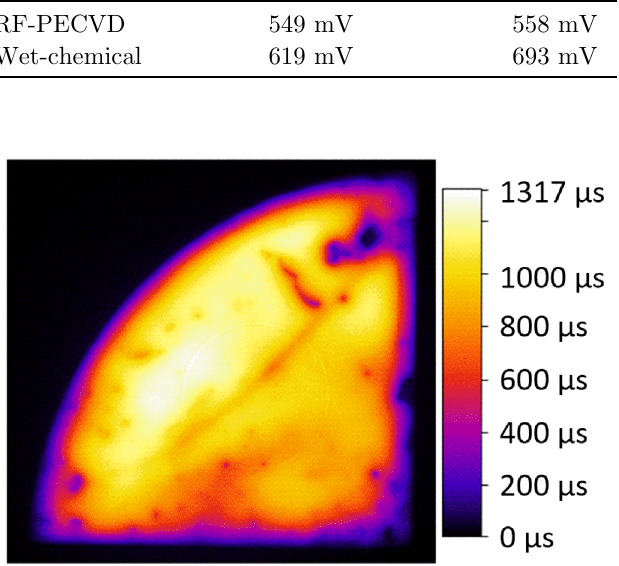
Fig. 5. Photoluminescence image calibrated in lifetime of a p - type FZ DSP 1/4 wafer passivated by a wet SiO x \( p + ) m c-Si \SiN x :H stack (Batch 3) with no annealing